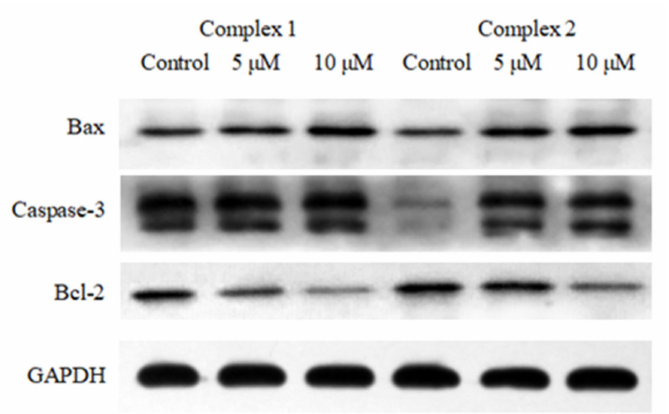
Figure 14. Western blot of Bax, caspase 3, and Bcl-2 in HepG2 cells inoculated with 5 µ M or 10 µ M complex 1 or complex 2 . GAPDH was the internal control.